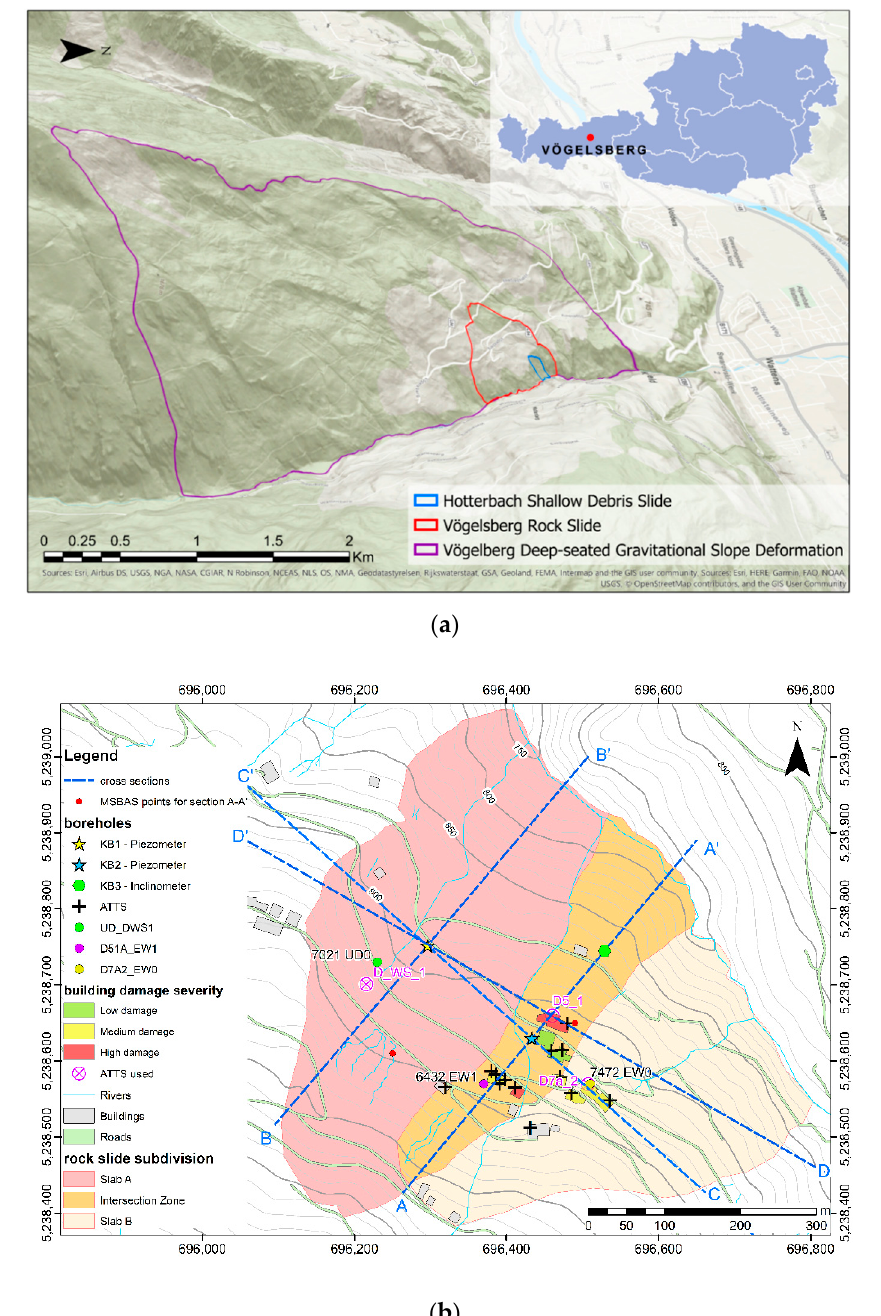
Figure 1. ( a ) location of the Vögelsberg DSGSD (in purple), the analyzed slow ‐ moving rockslide (in red), and the shallow debris slide (in blue), underground Open Street Map overlaid to digital elevation model (1.3 × vertical exaggeration); ( b ) location of the in ‐ situ and ancillary data available for the Vögelsberg rock slide together with the longitudinal (A ‐ A’ and B ‐ B’) and cross profiles (C ‐ C’ and D ‐ D’) selected for the application of the VIM method using MSBAS.